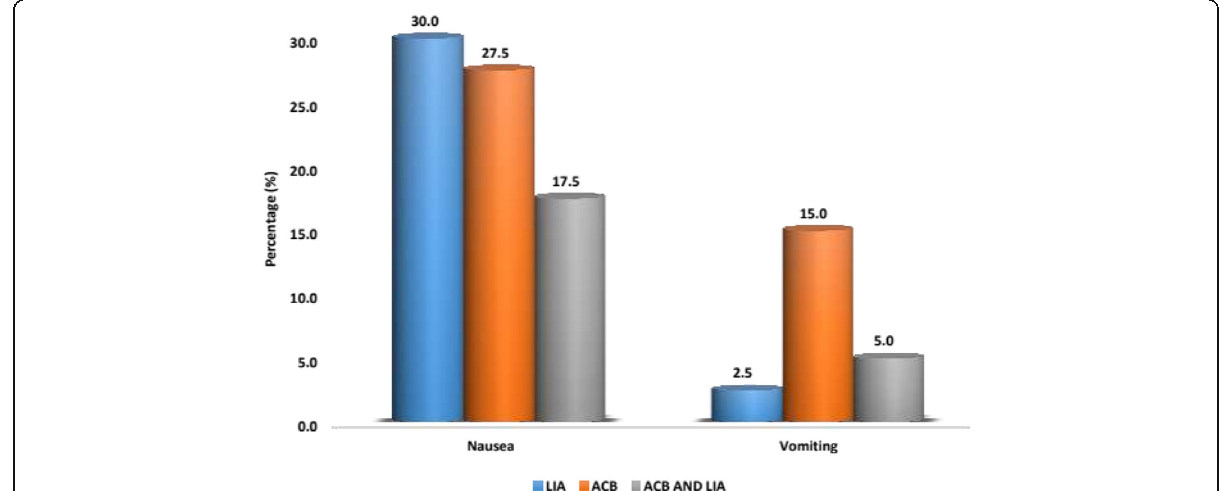
Fig. 8 Percentages of nausea and vomiting in each